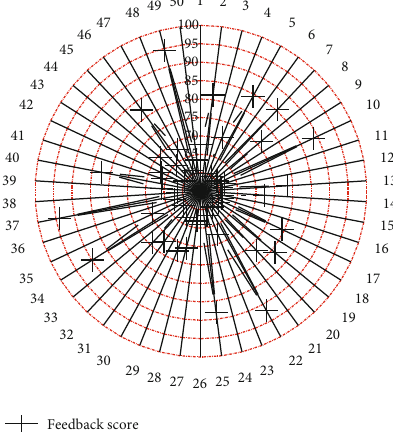
Figure 1: Score statistics of multivoice chorus